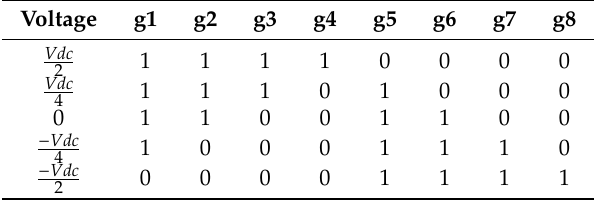
Table 7. Comparative assessment of various multilevel inverters.